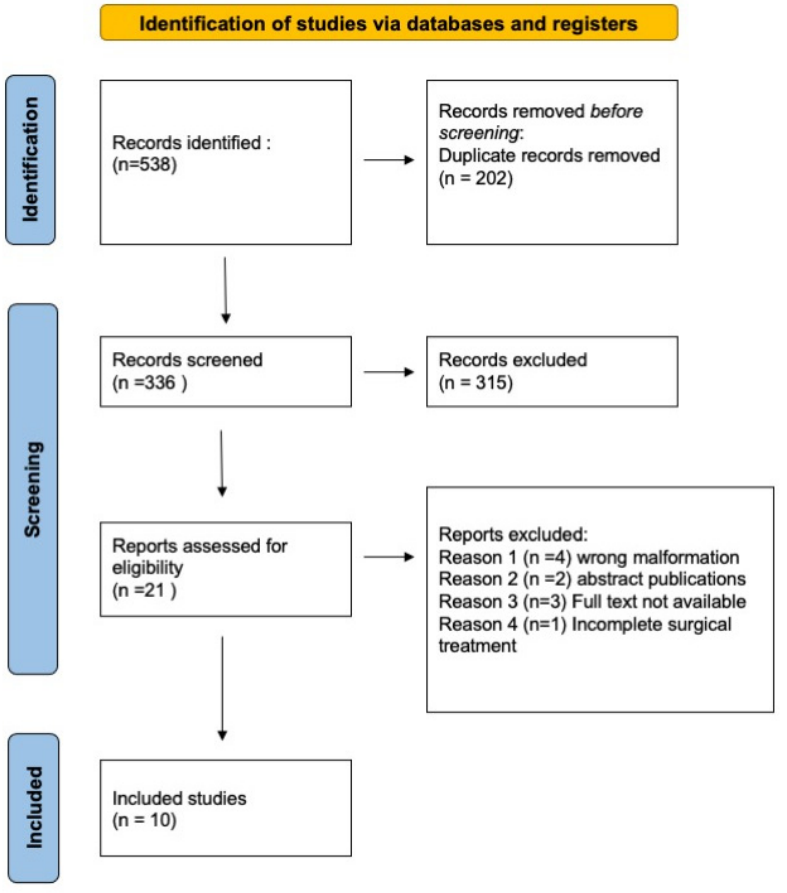
Figure 1. PRISMA flow diagram.